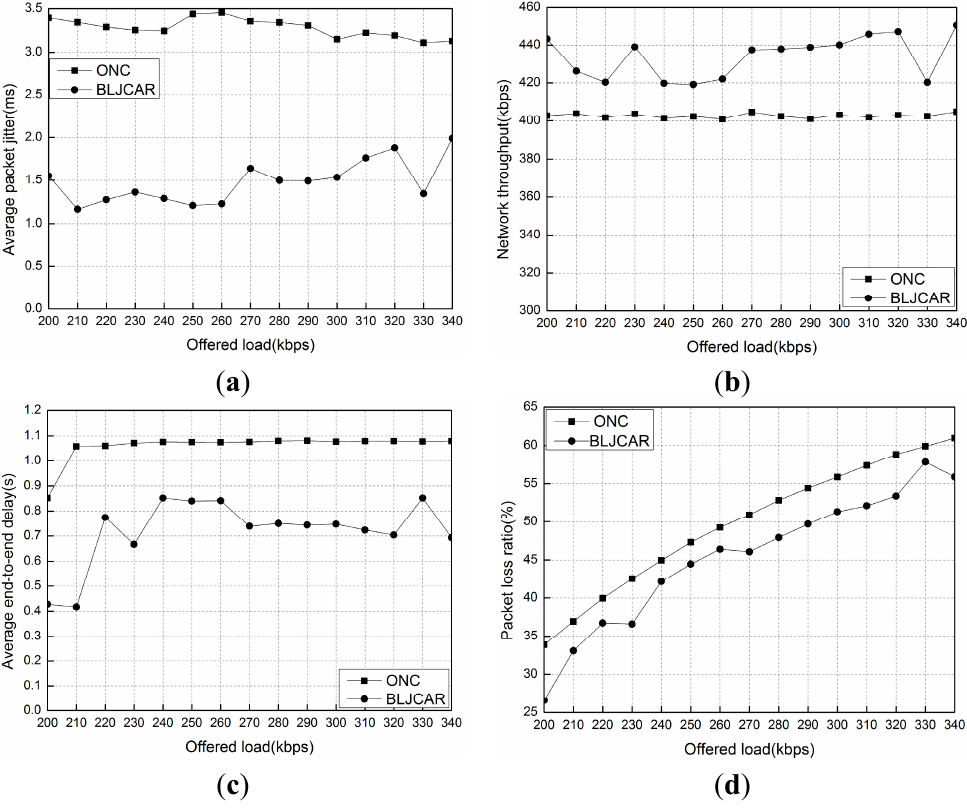
Figure8. ( a ) Average packet jitter versus offered load; ( b ) Network throughput versus offered load; ( c ) Average end-to-end delay versus offered load; ( d ) Packet loss ratio versus offered